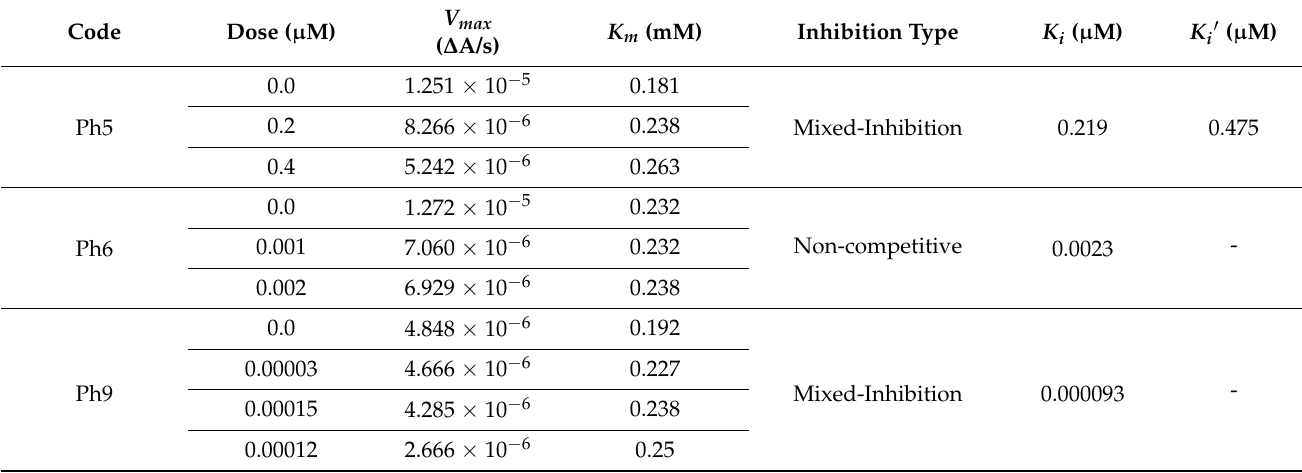
Figure 3. Lineweaver–Burk plots for inhibition of tyrosinase in the presence of 2-((4-methoxyphenethyl)amino)-2- oxoethyl(E)-3-(2,4-dihydroxyphenyl)acrylate (Ph9). ( A ) Concentrations of Ph9 were 0, 0.00003, 0.00006 and 0.00012 µ M, respectively. Substrate L -DOPA concentrations were 0.125, 0.25, 0.5, 1 and 2 mM, respectively. ( B ) The insets represent the plot of the slope and ( C ) of the vertical intercepts versus inhibitor Ph9 concentrations to determine inhibition constants. The lines were drawn using linear least-squares fit. Table 2. Kinetic parameters of the mushroom tyrosinase for L -DOPA activity in the presence of different concentrations of compound Ph5, Ph6 and